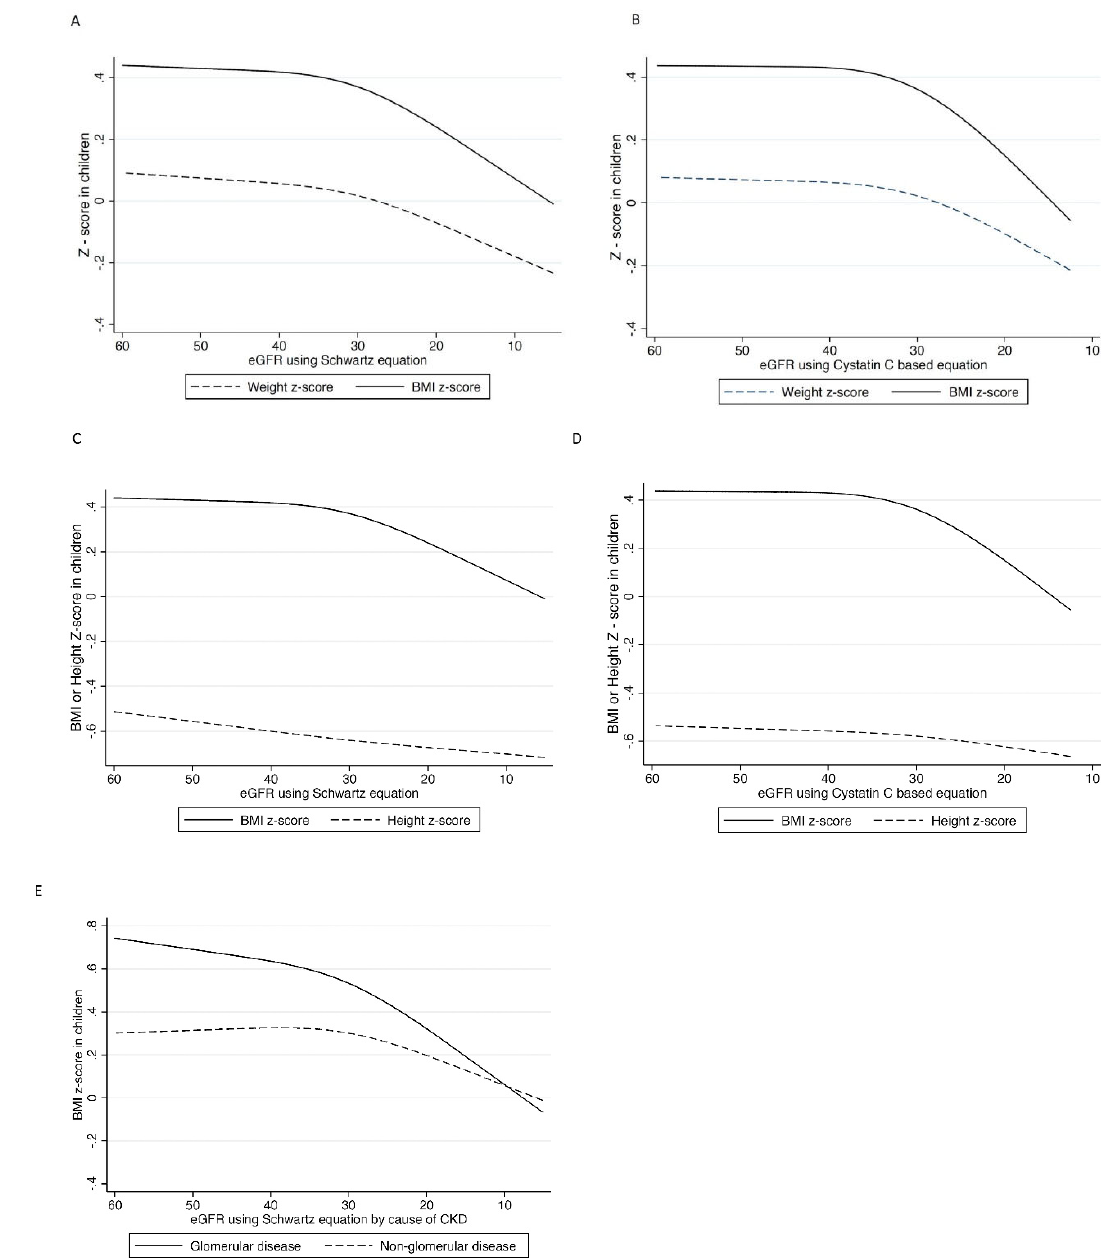
Figure 3. Association between longitudinal repeated measures of body mass index, weight, and height z score with repeated measures of kidney function over time in the Chronic Kidney Disease in Children study in the overall cohort, and by cause of CKD (glomerular versus non-glomerular disease). ( A ) Repeated measures of BMI and weight z scores with repeated measures of eGFR by serum creatinine. ( B ) Repeated measures of BMI and weight z scores with repeated measures of eGFR by cystatin C. ( C ) Repeated measures of BMI and height z scores with repeated measures of eGFR by serum creatinine. ( D ) Repeated measures of BMI and height z scores with repeated measures of eGFR by cystatin C. ( E ) Repeated measures of BMI with repeated measures of eGFR by serum creatinine by glomerular versus non-glomerular causes of CKD. Reprinted from Am J Kidney Dis., Vol. 71, Ku, E. et.al., Associations Between Weight Loss, Kidney Function Decline, and Risk of ESRD in the Chronic Kidney Disease in Children (CKiD) Cohort Study, Pages 648–656, Copyright (2018), with permission from the National Kidney Foundation, Inc., New York, NY, USA [28] .